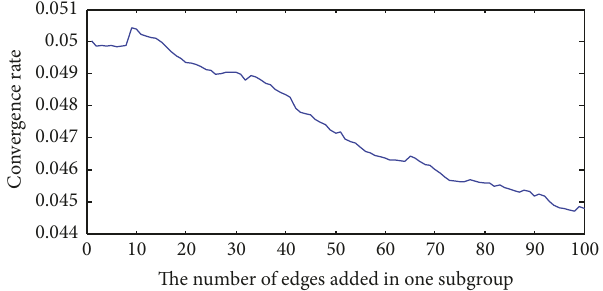
Figure 2: The relationship between the number of edges added in one subgroup and the convergence time.